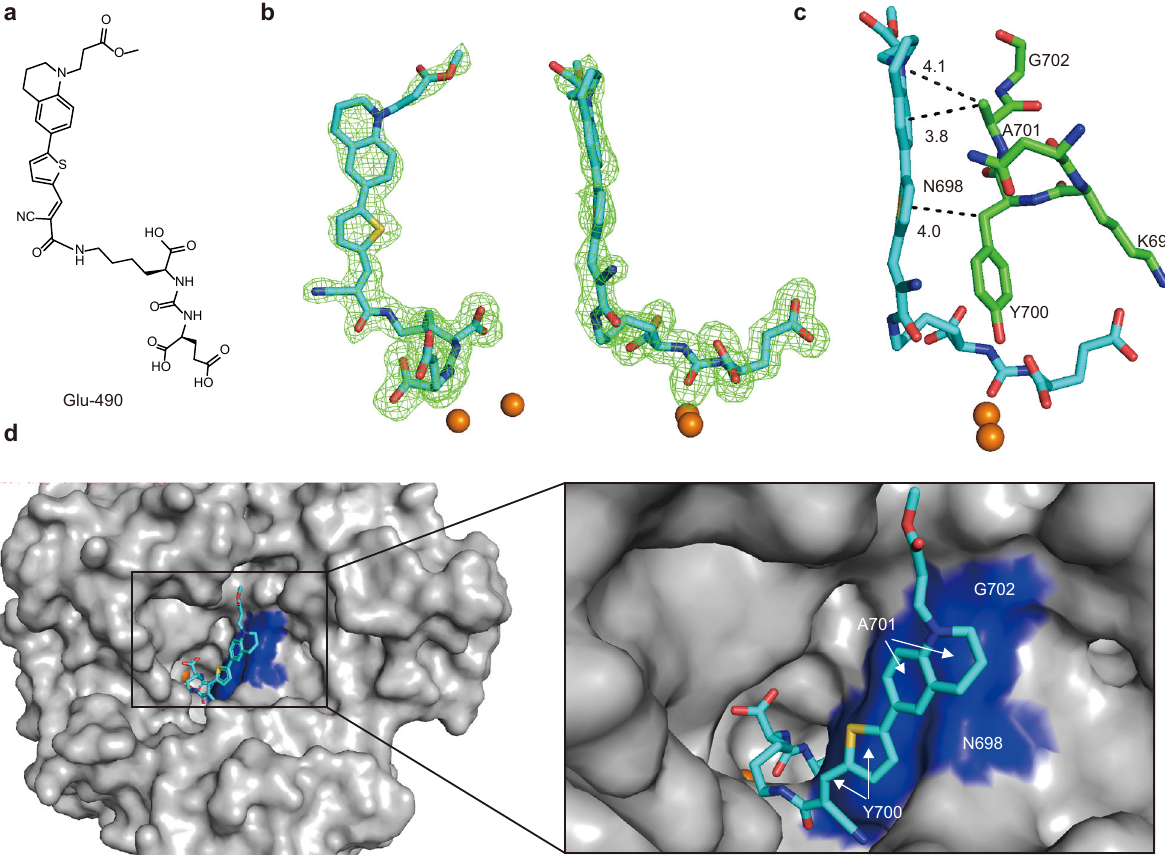
Fig. 2 Structural characterization of the PSMA/Glu-490 complex. a Molecular formula of the Glu-490. b A stereo view of the Gluo-490 inhibitor. The Fo- Fc omit map (green) is contoured at 3.0 σ and the inhibitor is shown in stick representation with atoms colored red (oxygen), blue (nitrogen), yellow (sulfur), and cyan (carbon). c Details of interactions between residues of the glutarate sensor (green carbons) and Glu-490 (cyan carbons). CH – π interactions are depicted as dashed lines with distances to the ring centers in Angstroms. The active-site zinc ions are shown as orange spheres. d Surface representation of PSMA with residues of the glutarate sensor interaction with the FMR moiety colored blue, PDB code